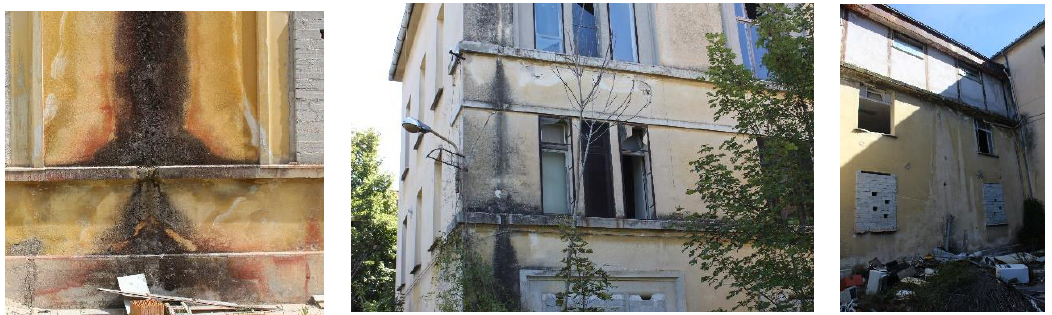
Figure 10. Examples of degradation outside the building.